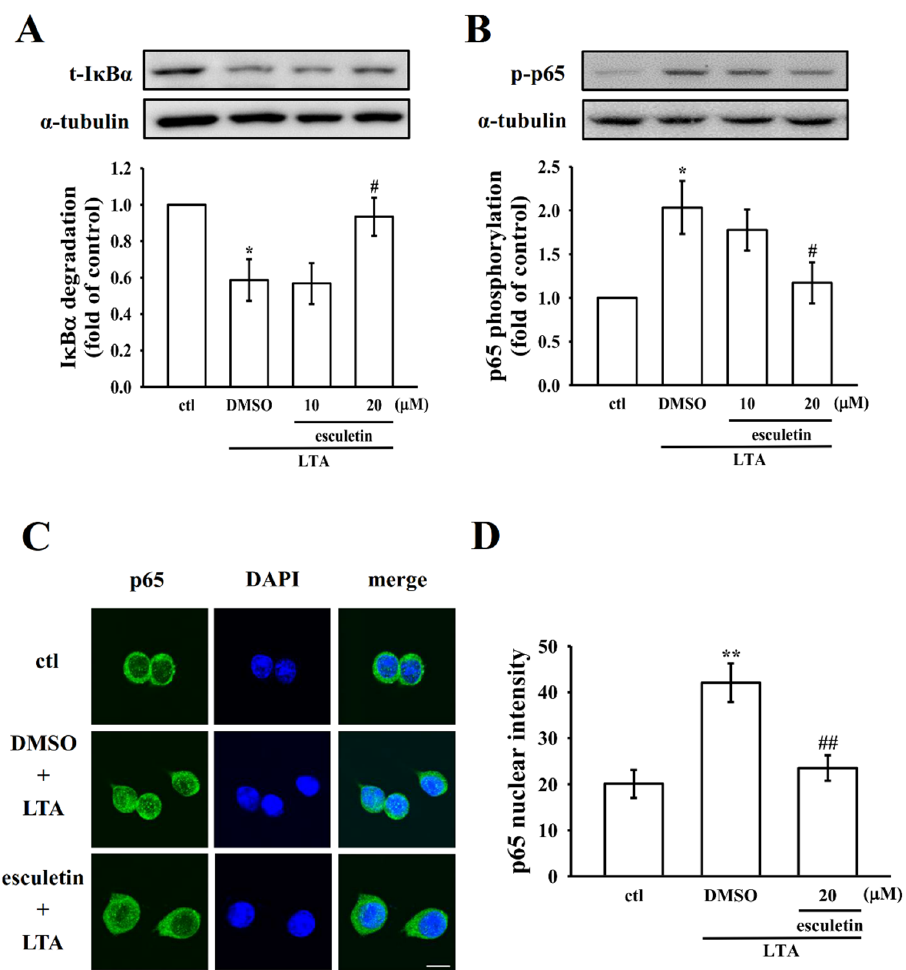
Figure 4. Esculetin regulates the nuclear factor kappa B (NF- κ B) signaling pathway that was in- duced by LTA in RAW cells. Cells were treated with esculetin (10 and 20 µM) and LTA (10 µg/mL) for 1 h. Western blotting assay was performed to detect ( A ) the degradation of I κ B α and ( B ) the phosphorylation of p65 in LTA-induced RAW cells. ( C ) Esculetin inhibited LTA-induced p65 nuclear translocation (scale bar = 10 µm). ( D ) Data were graphed by pooling multiple images, with each individual data point corresponding to the mean fluorescence intensity of each individual cell nucleus. Data are presented as the means ± SEM ( n = 4). * p < 0.05 and ** p < 0.01, compared